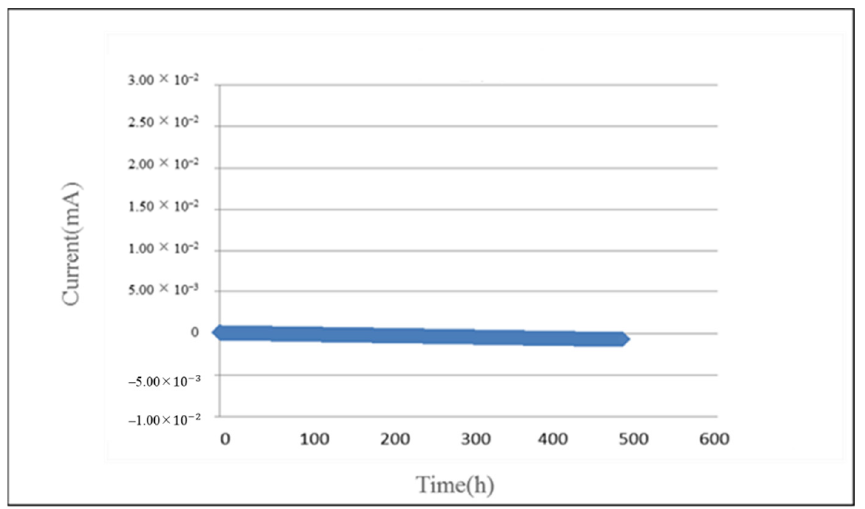
Figure 16. Curve of voltage inside PEM water electrolyzer. The current of PEM water electrolyzer decreases from 0.15 mA to 0.12 mA in the 500-h operation test, as shown in Figure 17.